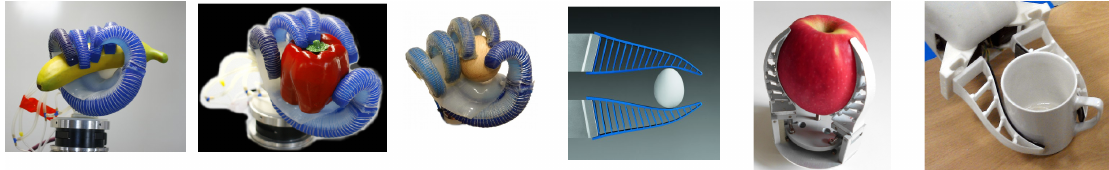
Figure 2. A sample of deformations when flexible robotic grippers grasp an object.